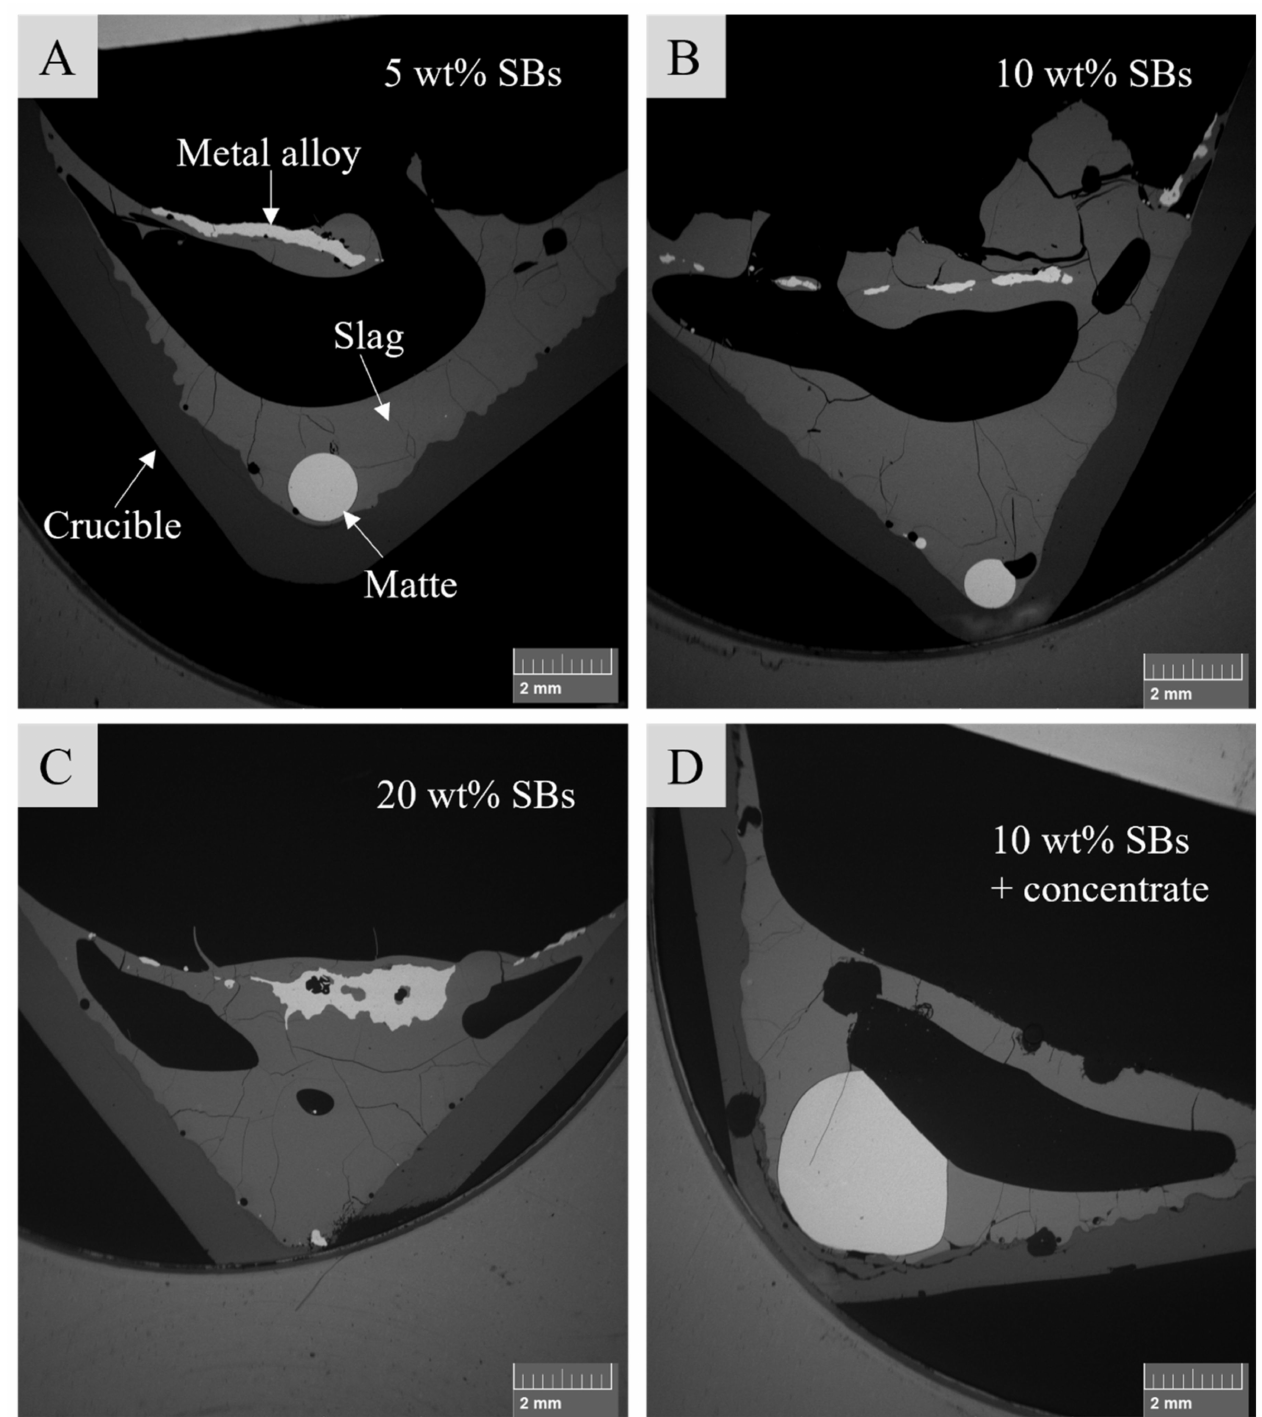
Figure 1. Microstructures of samples with different starting mixtures ( A —5 wt% SBs; B —10 wt% SBs; C —20 wt% SBs; D —10 wt% SBs + concentrate) after 40 min contact time at 1350 ◦